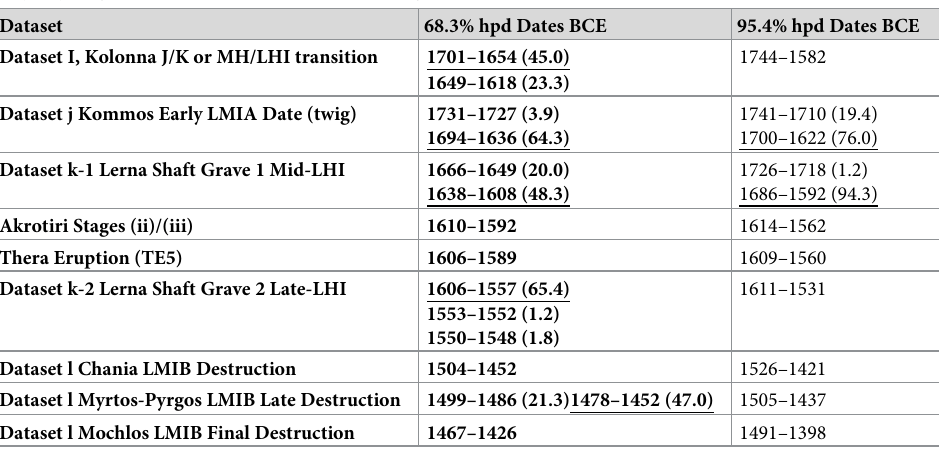
Table 5. Modelled results (bold = 68.3% hpd, and non-bold = 95.4% hpd) for the datasets shown in Fig 10. The majority range where there are two or more split ranges is underlined.